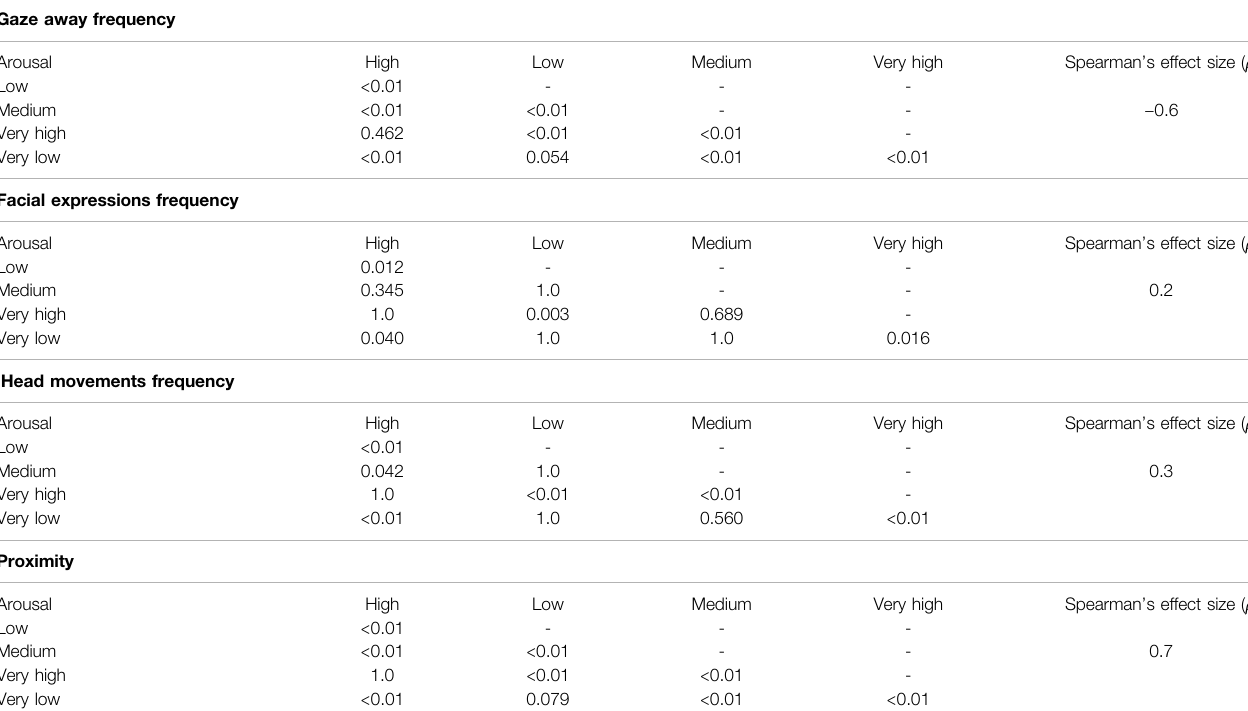
TABLE2| Wilcoxon ’ sPairwiseTests,numbersare p -valuesfromeachtests,thelevelsofarousalareonbothsidesofthetablewiththeSpearman ’ seffectsizeforthearousal and the four variables. Gaze away frequency